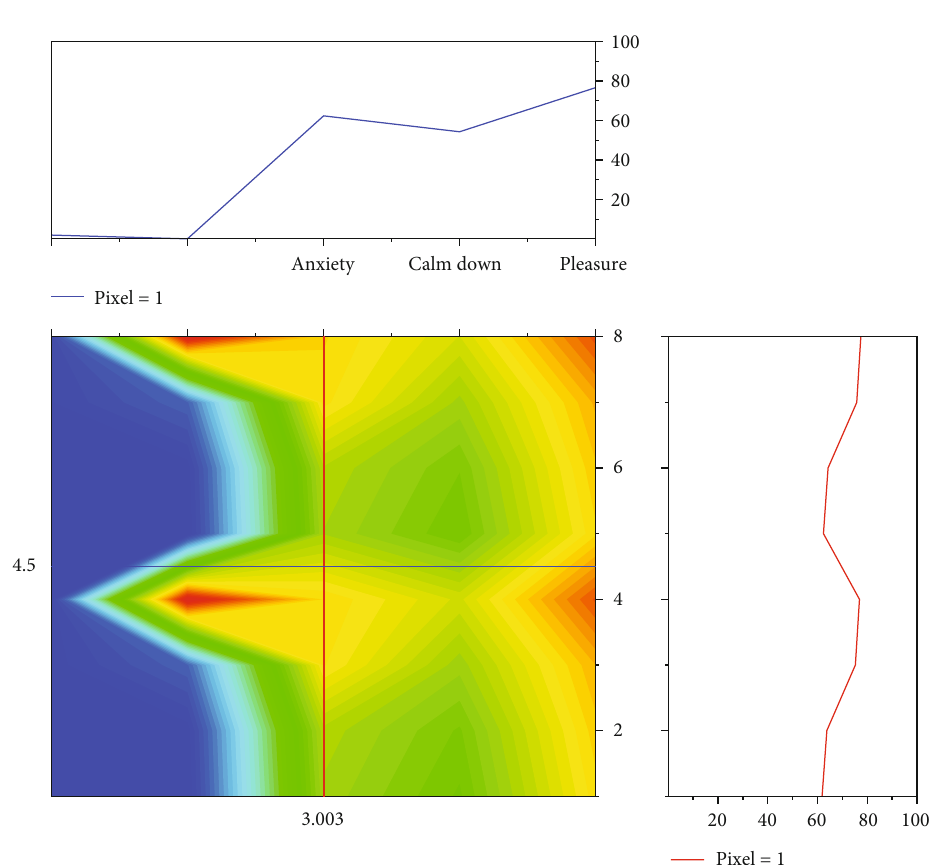
Figure 5: Accuracy of di ff erent parameters for identifying anxiety and calming